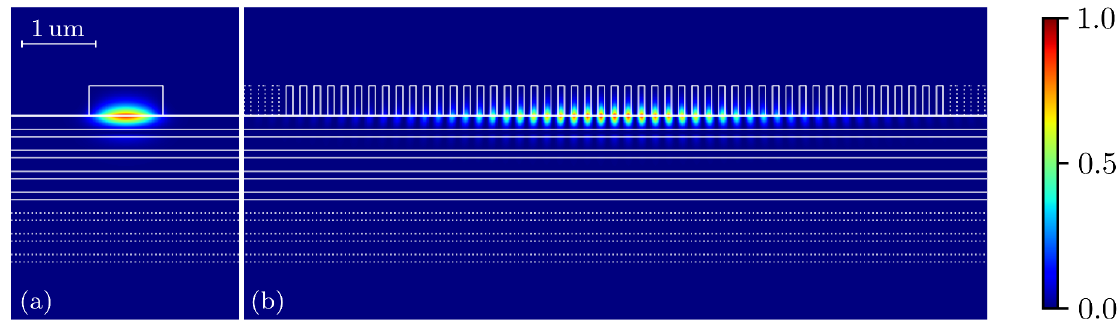
Figure 3. Intensity profile (normalized to the maximum value) of the electric field of the fundamental mode as obtained from FDTD simulations. (a) PhC-ridge cross section. (b) Nanobeam cross